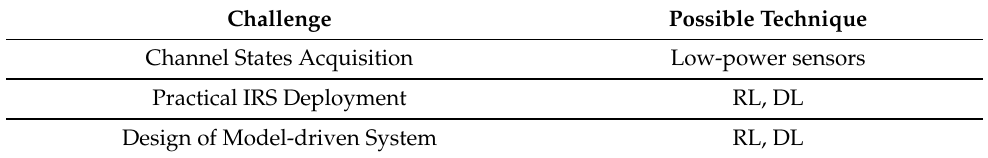
Table 7. Challenges for IRS